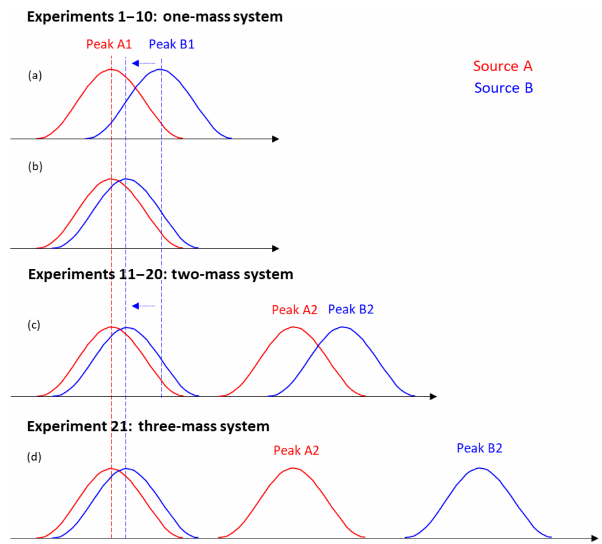
Figure 3. Conceptual schematic diagram for the synthetic datasets. Panels (a) and (b) describe experiments 1–10 in the one-mass sys- tem; panel (c) describes experiments 11–20 in the two-mass system. Panel (d) shows experiment 21, with peaks A2 and B2 at separate integer masses (see text for